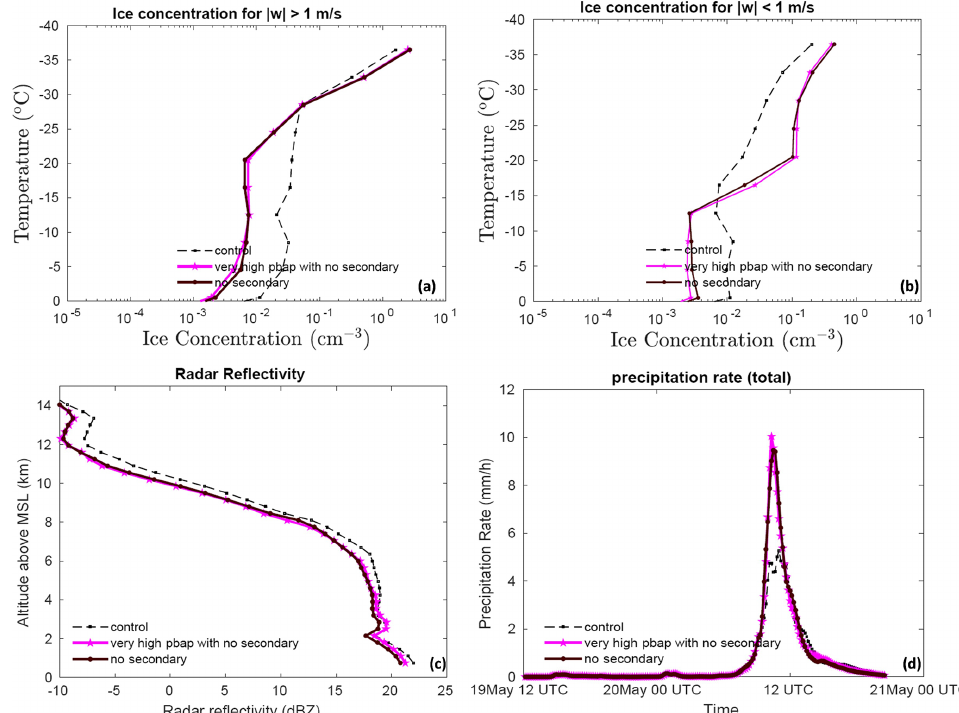
Figure 10. The temperature dependence of the ice number concentration for the control, very high PBAP with no SIP, and no SIP simulations averaged for (a) convective and (b) stratiform regions. The (c) vertical profile of the radar reflectivity and the temporal evolution of the (d) surface precipitation rate are shown for the entire simulation. All the vertical profiles shown here are averaged for the whole